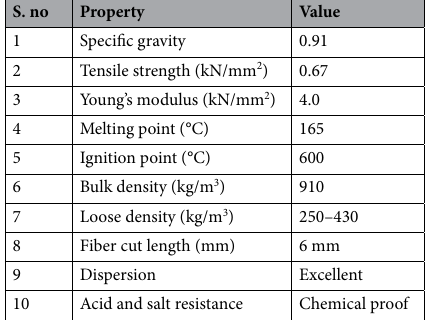
Table 2. Properties of polypropylene fiber considered 45 .